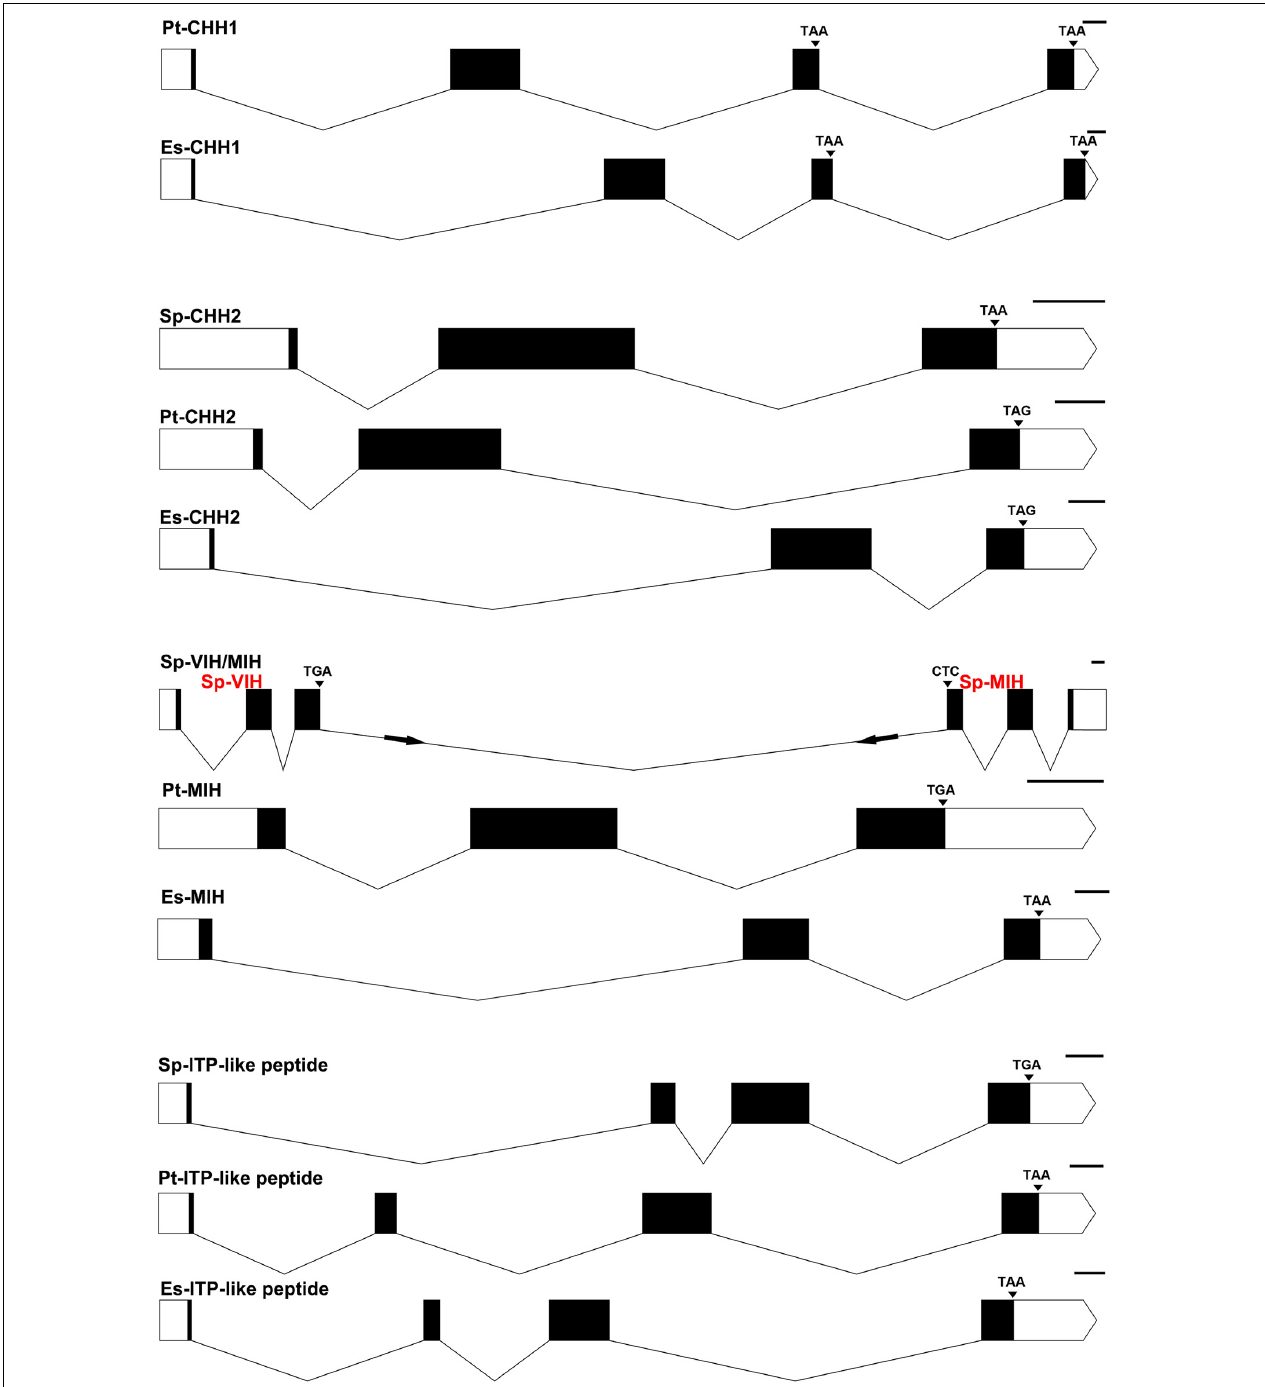
FIGURE 1 | Gene structures of CHHs obtained from genomic assembles of S. paramamosain, P. trituberculatus , and E. sinensis . Schematic diagrams showing the genomic structures of CHH1 , CHH2 , MIH/VIH , and ITP-like peptide identified in S. paramamosain, P. trituberculatus , and E. sinensis . Blocks and lines represent exons and introns, respectively. Black areas of the blocks represent the coding sequence (CDs) of CHHs. Scale length is 100 base pair.